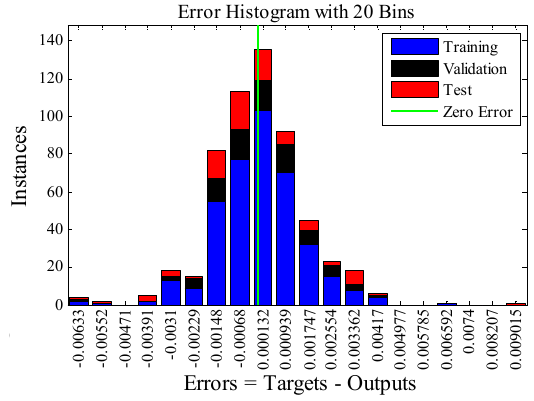
Figure 16. Performance of MSE of training, testing, and validation data for the LOS environments.